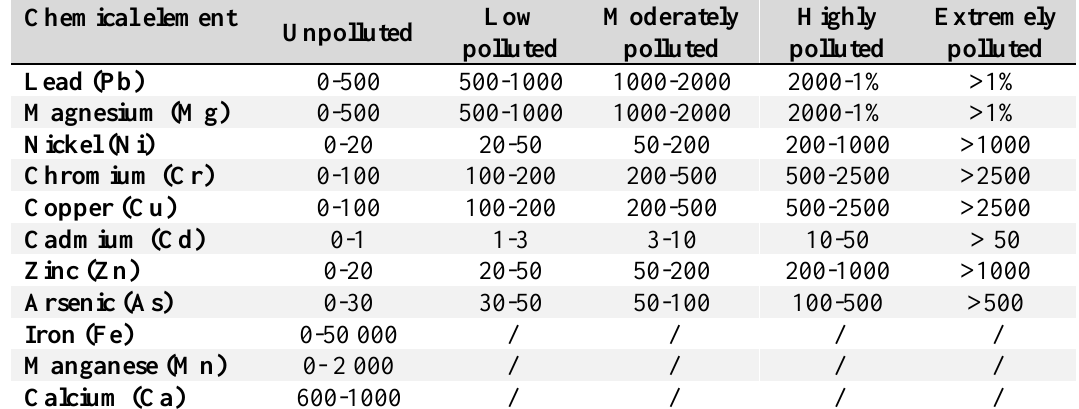
Table 1. Classification of contaminated soil according to heavy metal content (mg/kg) (S ORIANO et al ., 2010; K ABATA -P ENDIAS ,